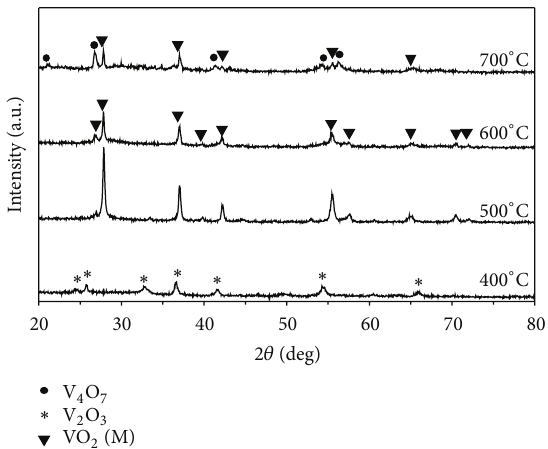
Figure 3: XRD patterns of vanadium oxide powders prepared by microwave heating at 300 W and then calcinations at different temperatures for 1 h.